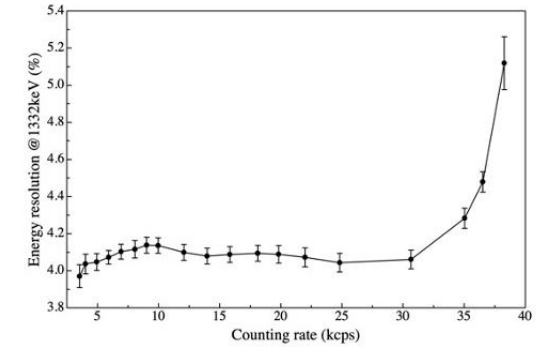
Figure 2: Energy resolution as a function of the counting rate for the CLLB detector.